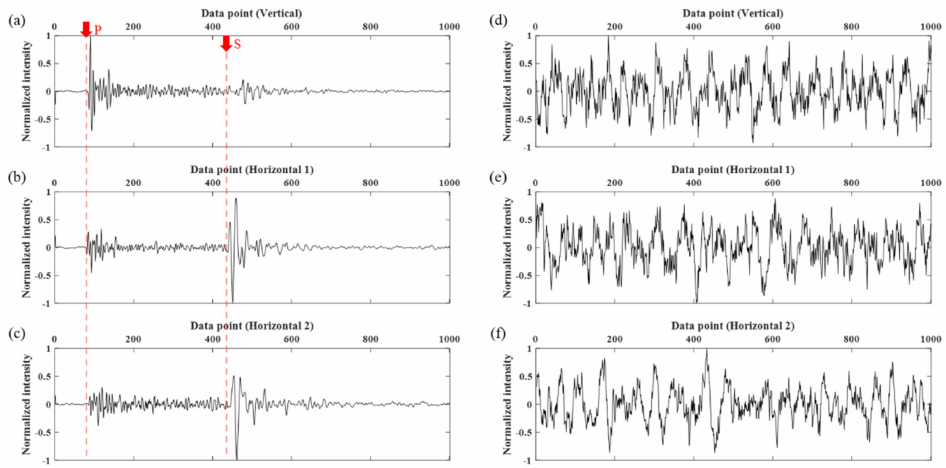
Figure 10. Normalized microseismic data for vertical and horizontal directions in the second ( a – c ) signal and ( d – f ) noise sample.